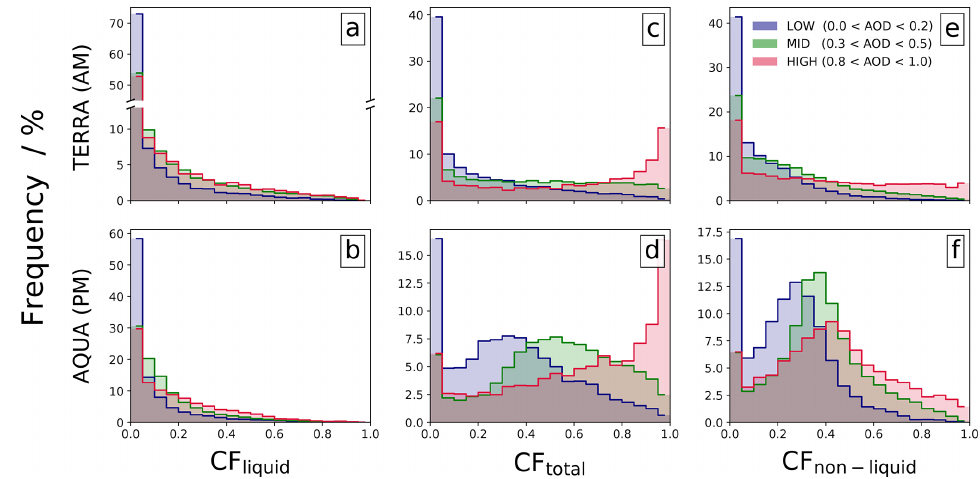
Figure 8. Normalized probability of occurrence of CF liquid (a–b) , CF total (c–d) , and CF non-liquid (e–f) for low- (0.0 < AOD < 0.2), mid- (0.3 < AOD < 0.5), and high (0.8 < AOD < 1.0) AOD scenes. The top row shows the TERRA overpass in the morning, and the bottom row shows the AQUA overpass in the afternoon. Note the break in the y axis in panel (a) .